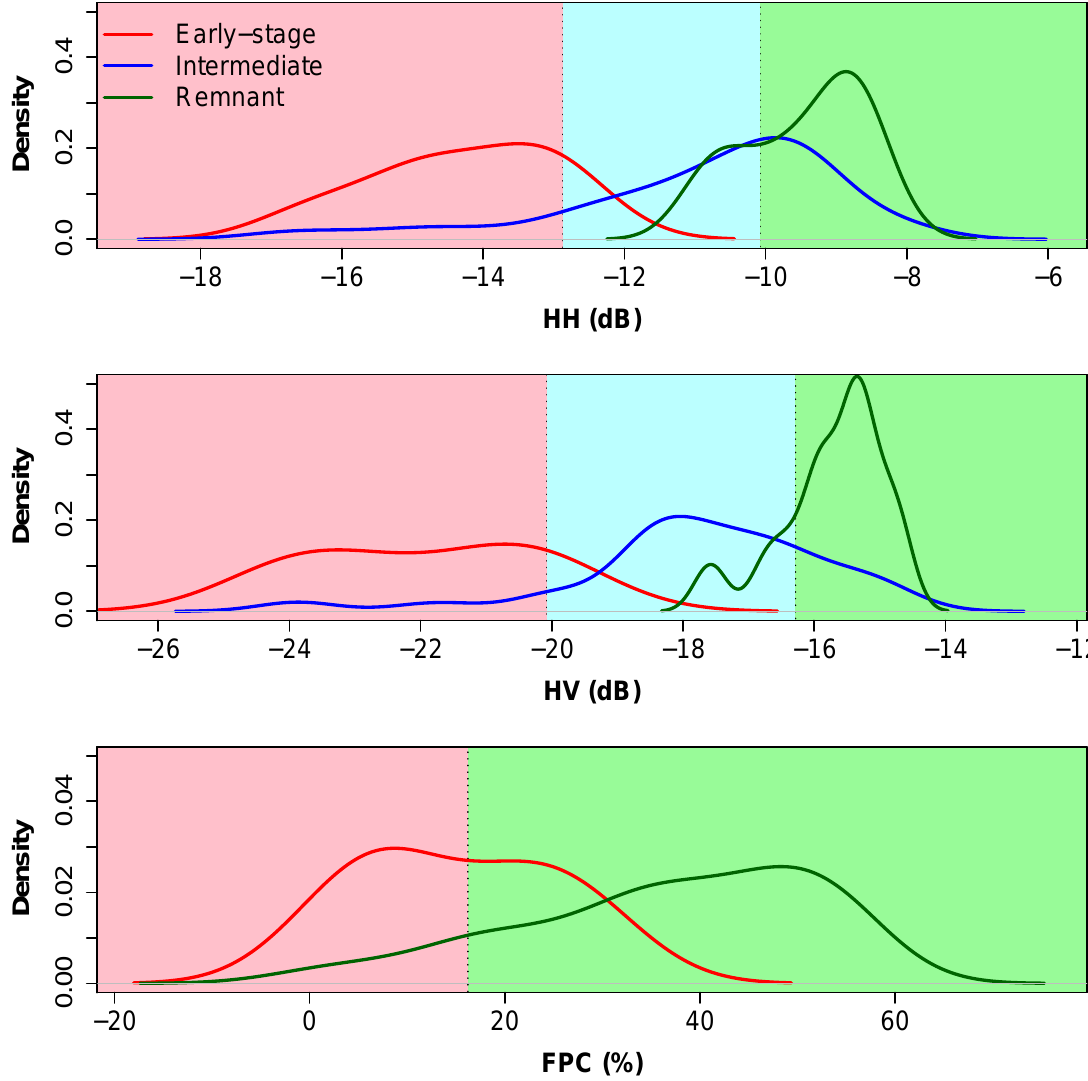
Figure 3. Normalised field plot density for HH- and HV- polarisation backscatter and FPC within each stage of regrowth (solid lines). The shaded areas represent areas corresponding to a z -score of 2, calculated using Equation (1), and assuming the same standard error for each object and reference data for early stage and remnant regrowth. The shaded blue area represents objects that have a z -score > 2 for early stage regrowth and < 2 for remnant, and which are assigned to the intermediate regrowth stage. No significant differences between intermediate and remnant forests were observed when using FPC data, and hence these were